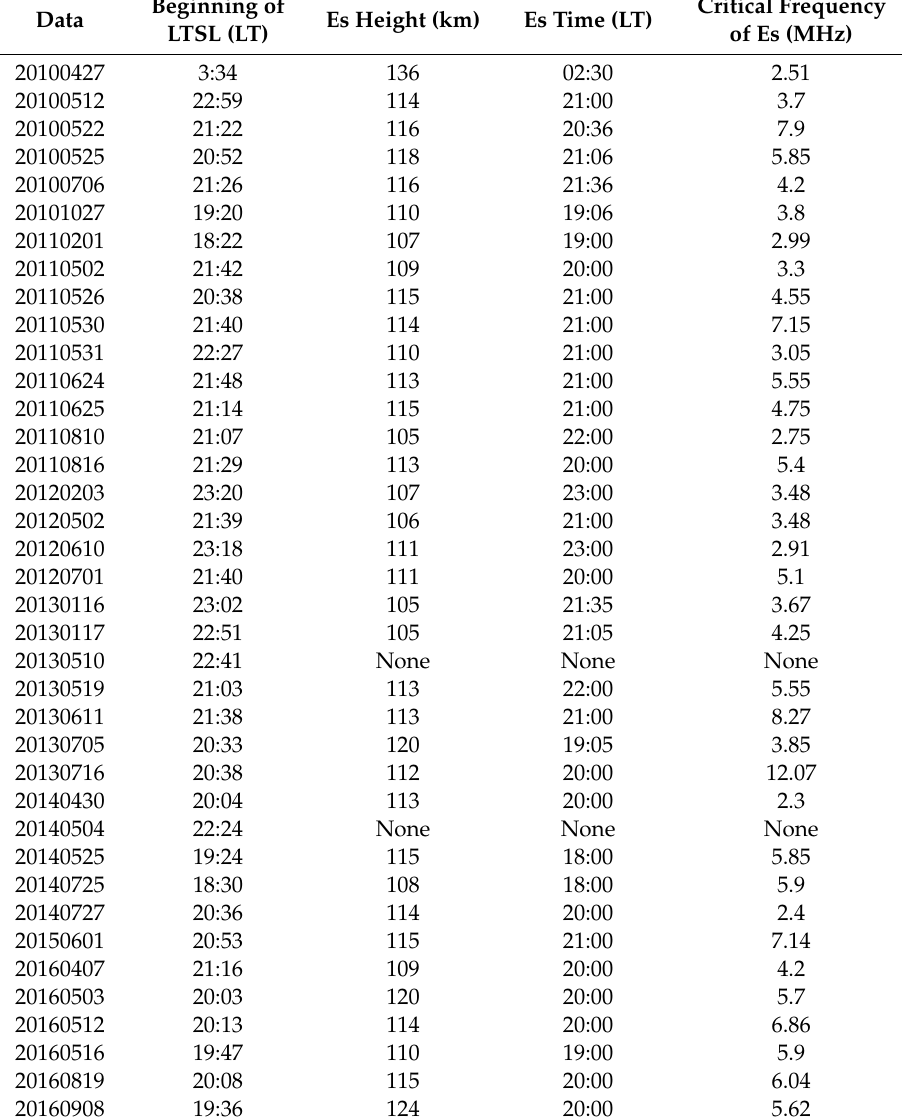
Table 2. The parameters of the Es